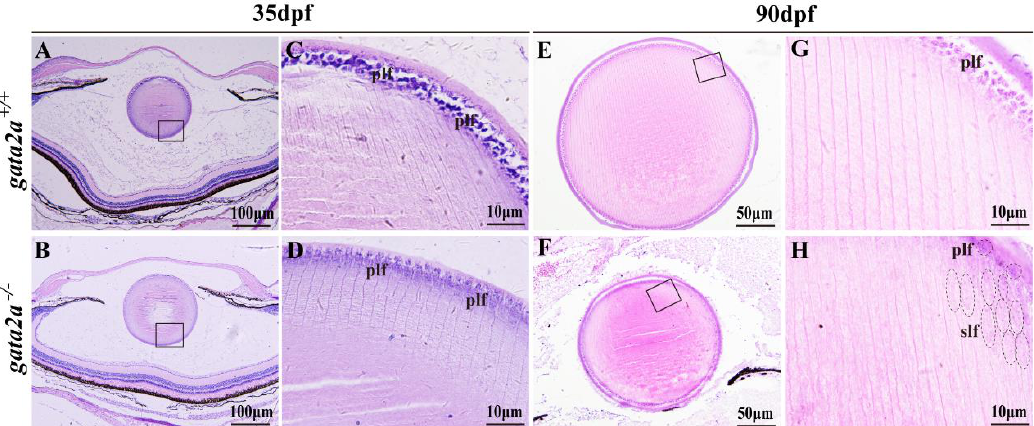
Figure 4. Histological analysis of the eyes from WT and gata2a mutants at 35 and 90 dpf. ( A – D ) Histology of the eyes at 35 dpf, the size of the lens from gata2a mutants were similar to that of WT ( A , B ), while most of the primary lens fiber cells were degenerated ( C , D ). ( E – H ) Lens from gata2a mutants were smaller and opaque compared to those from WT siblings ( E , F ). Most of the primary lens fiber cells in the gata2a mutants were degenerated, and the nuclei were not degraded in some of the secondary lens fiber cells ( G , H ). C, D, G, and H are magnifications of the boxed areas in A, B, G, and H, respectively. dpf: day post fertilization. plf: primary lens fiber cell; slf: secondary lens fiber cell. The dotted circles and ellipses in the H diagram represent primary and secondary lens fiber cells, respectively.